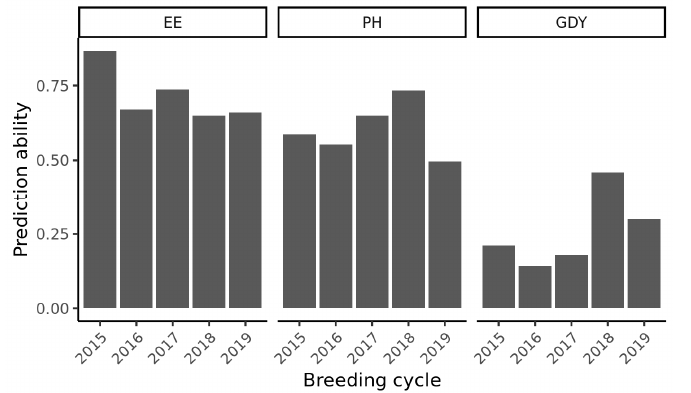
Figure 2. Prediction abilities for the traits ear emergence (EE), plant height (PH) and grain yield (GDY) across breeding cycles, where each breeding cycle was predicted based on a training set com- prising only genotypes from the remaining breeding cycles. comprising only genotypes from the remaining breeding